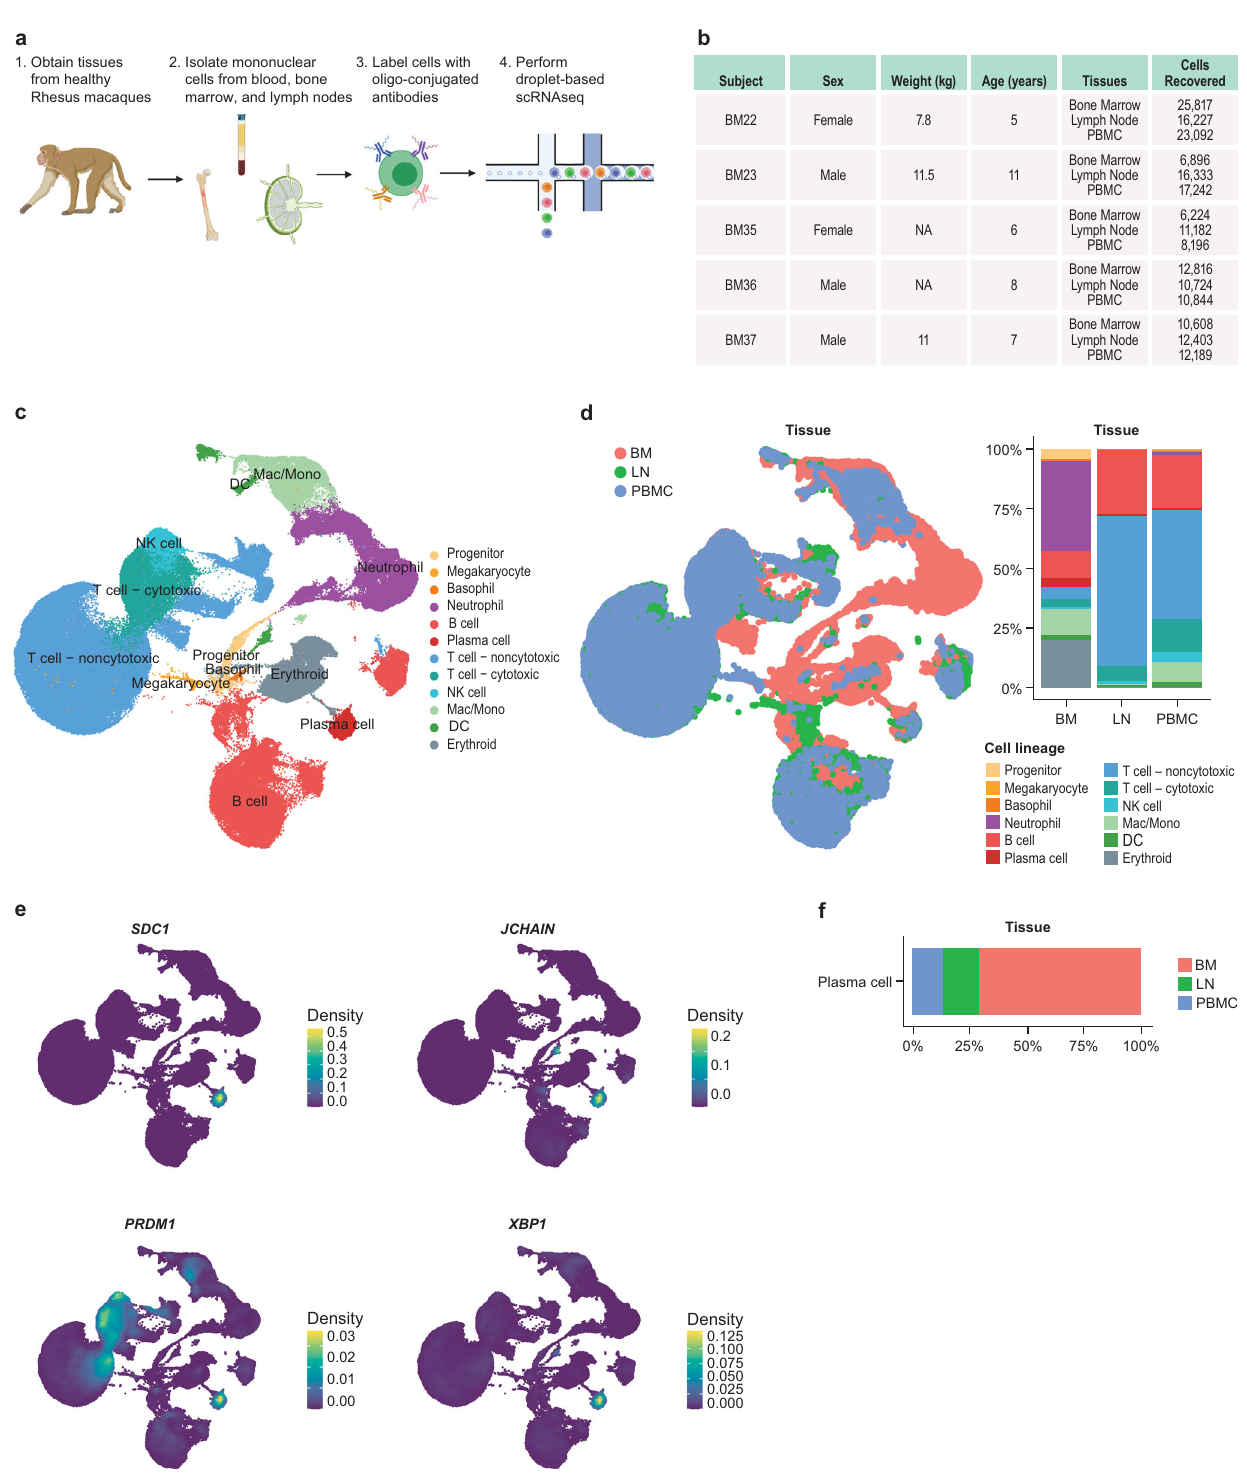
Fig. 2 Multi-modal single-cell atlas of rhesus macaque immune tissues. a Experimental design for rhesus single-cell data generation. Tissues were collected from healthy rhesus macaques. Single-cell suspensions were isolated from fresh blood, lymph nodes, and bone marrow. To enable pro fi ling of cell surface proteins, cells were labeled with a panel of 124 oligo-conjugated antibodies before being subjected to droplet-based single-cell RNAseq on the 10x Chromium platform. Diagram created with BioRender.com. b Table of animal subject metadata for NHP included in single-cell multi-omic analysis and number of cells recovered across tissue compartments assessed. NA indicates data not available. c UMAP visualization of cells derived from NHP BM, LN, and PBMC. Cells are colored by major cell lineage. d Left panel: UMAP visualization of cells by tissue of origin. Right panel: Distribution of major cell lineages by tissue. e Expression of canonical PC genes at the RNA level. Expression is visualized as the kernel density estimate for each RNA. f Proportions of PC across the three tissues pro fi